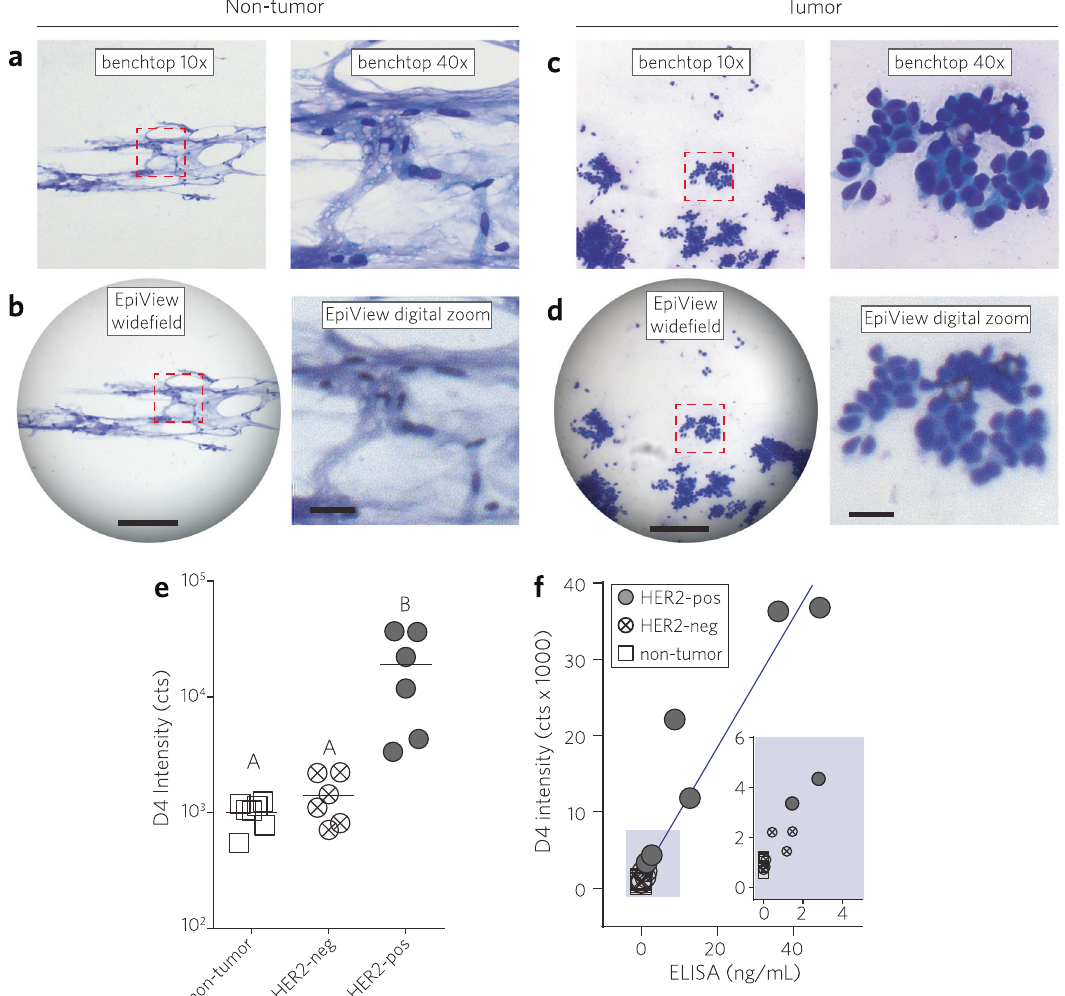
Fig. 5 Evaluation of tissues obtained from human patients with EpiView-D4. Bright fi eld cytology imaging of non-tumor human breast tissue specimens were sampled by FNA and imaged by standard benchtop microscopy ( a ) and bright fi eld imaging by EpiView ( b ). Left panels: LPF views by standard microscope equipped with a 10× objective lens (top) and native view on EpiView (bottom). Right panels: standard microscope image obtained by a 40× objective (top), showing the same ROI outlined with red dashed line in the 10× image, and a similar view obtained by digital zoom on the EpiView (bottom). Scale bars for LPF and HPF images are 0.2 mm and 30 µm, respectively. c , d Similar sequence of images as a and b but with a representative specimen with cytological evidence of tumor. e Results of HER2 credentialing by EpiView-D4 for 19 different patient breast tissue specimens: non-tumor, HER2-negative tumor, HER2-positive tumor ( N = 7, 6, 6, respectively). Each data point represents the mean D4 fl uorescence intensity (after background subtraction) of duplicate assays measured by the EpiView- D4 for an individual tissue specimen. The horizontal line represents the mean D4 signal intensity for each category. There was a statistically signi fi cant difference between groups as determined by one-way ANOVA (F (2, 16) = 9.264, p = 0.0021). Groups that are different by multiple comparison testing (Tukey post hoc test, p ≤ 0.05) are marked with different letters. HER2-positive tumors are de fi ned as IHC 3 + or IHC 2 + with HER2 ampli fi cation by FISH. f EpiView-D4 readout vs ELISA for HER2 for all patient specimens. A strong, positive correlation between EpiView-D4 and ELISA across the 19 paired measurements is observed, which was statistically signi fi cant (Pearson r = 0.956, p < 0.0001, 95% CI: 0.886 –